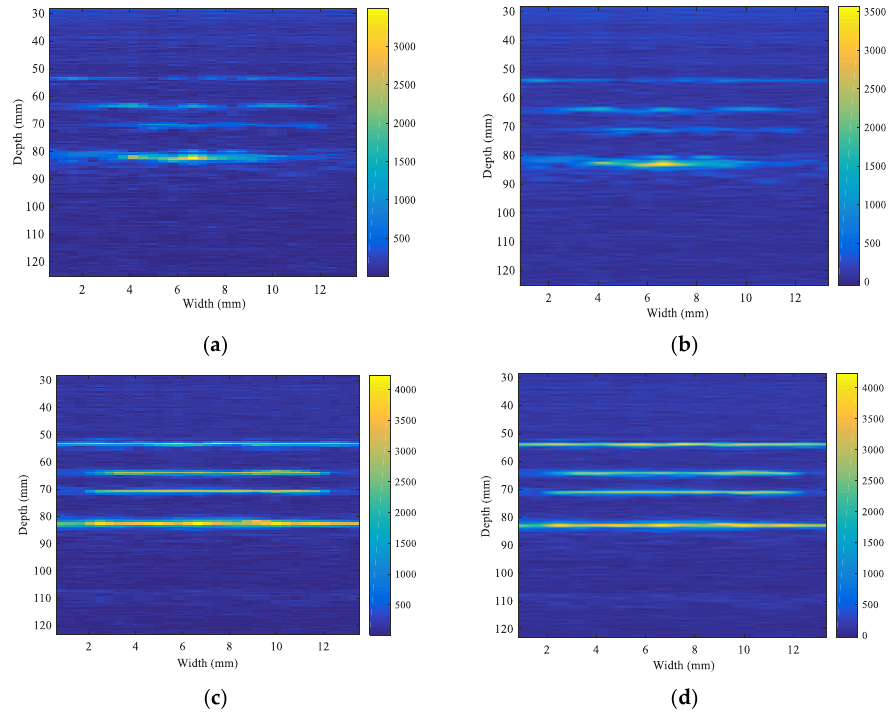
Figure 12. Imaging results: ( a ) conductivity distribution of the sfMAET-CPS; ( b ) conductivity distribution of the sfMAET-CPS after being processed by the linear interpolation algorithm; ( c ) conductivity distribution of the mfMAET-CPS; and ( d ) conductivity distribution of the mfMAET-CPS after being processed by the linear interpolation algorithm.